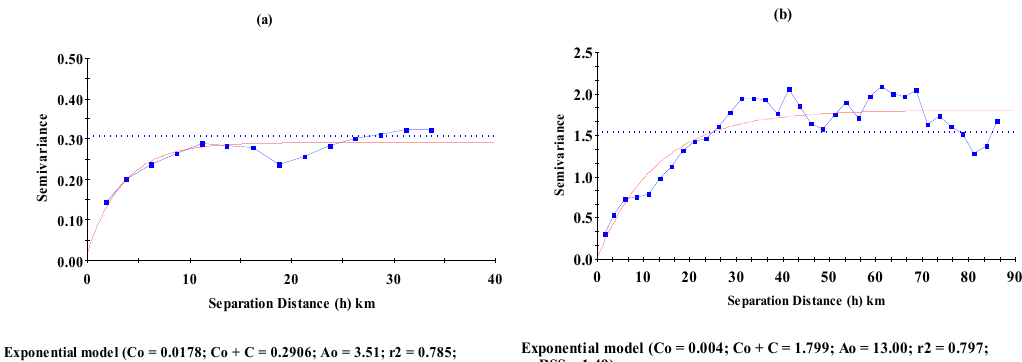
Figure 6. Variograms of log(T) values of the Kg ( a ) and Dm ( b ) aquifers.